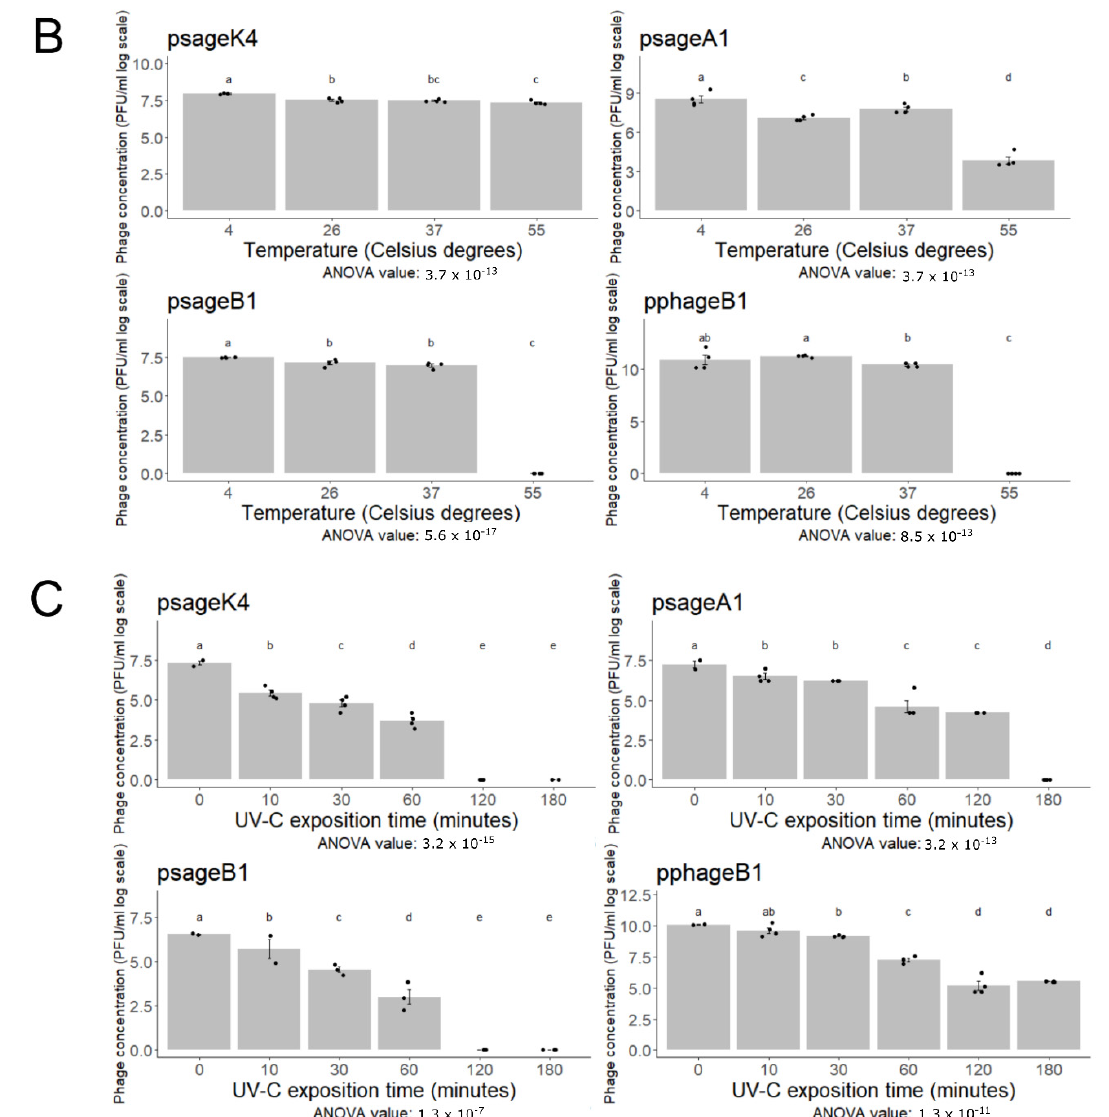
Figure 3. The charts show the viability of pphageB1, psageK4, psageB1 and psageA1 phages under exposure to different pHs ( A ), or temperatures ( B ), for one hour, and to different times of UV-C irradiation ( C ). The number of replicates for every condition is four, and the error bars indicate the standard error. The statistical significance was calculated through the agricolae R package and consists of ANOVA (ANOVA p -values are shown under every plot) and Kruskal–Wallis analysis (significant differences indicated by letters over the bars). Different lower-case letters above each bar plot represent statistically different